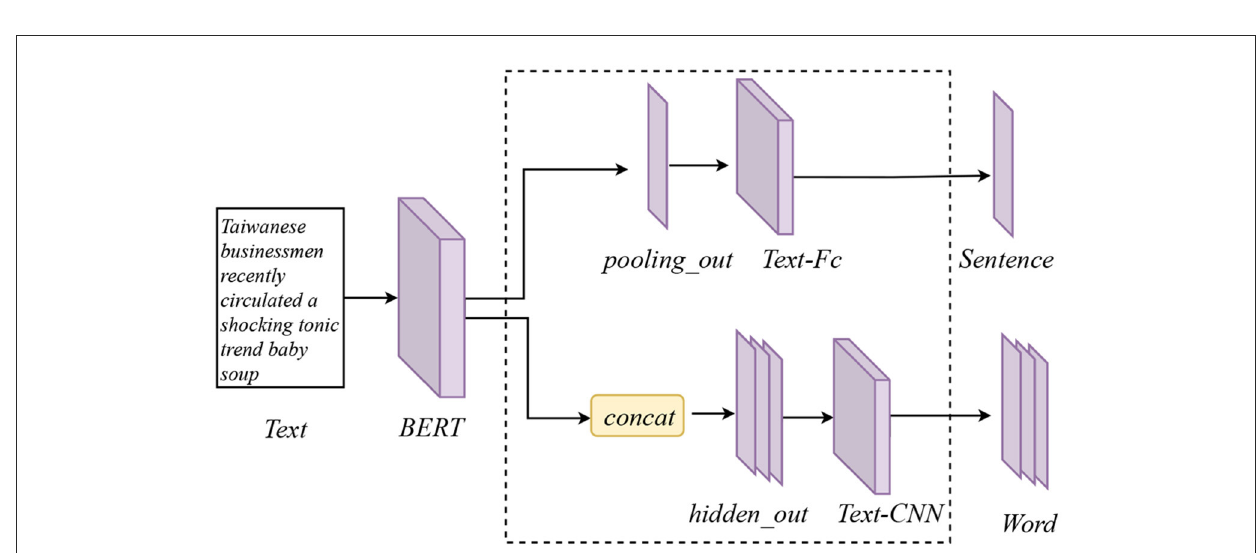
FIGURE2 Text feature extractor module. It contains two branches, the upper branch extracts the entire vector semantics of the sentence ( T f in Figure 1) and the lower branch is used to extract the word vector semantics ( T m in Figure